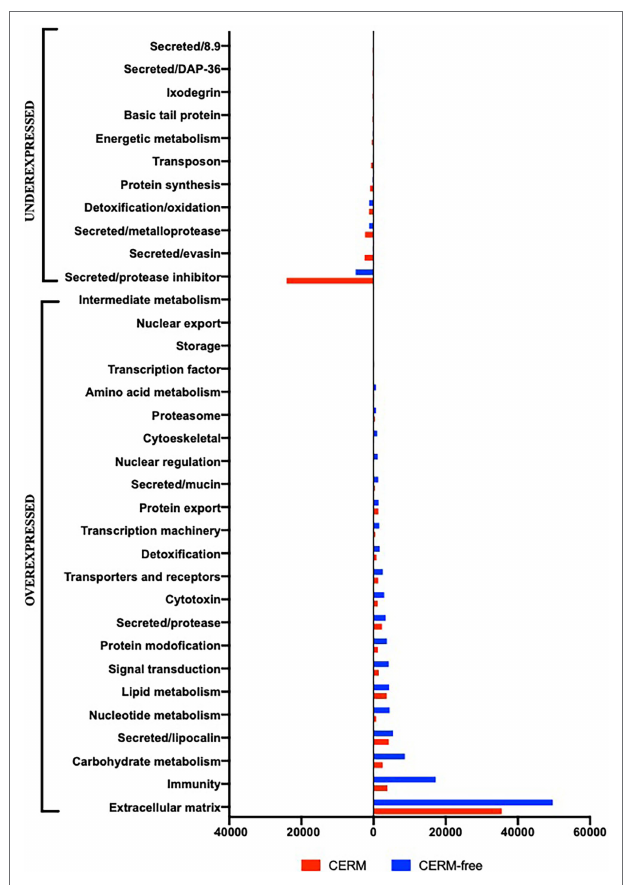
FIGURE 4 | Total TPM (transcripts per million) in each functional category for differentially expressed transcripts underexpressed and overexpressed in CERM ( Coxiella endosymbiont from Rhipicephalus microplus )-free metanymphs. Unknown and Unknown conserved categories were excluded from the